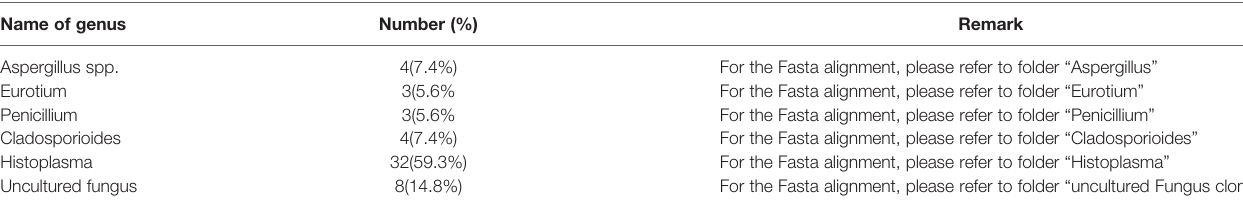
TABLE 1 | Histoplasma and other fungal genera identi fi ed by blasting the sequence data. Name of genus Number (%) Aspergillus